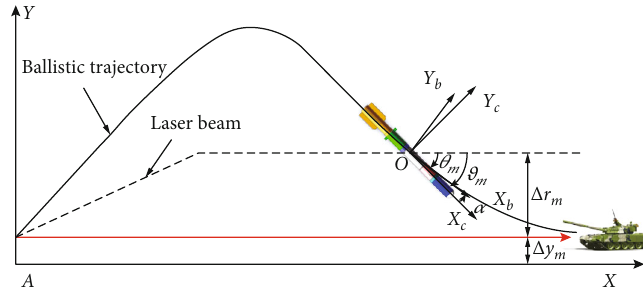
Figure 1: Relations of munition, target, and